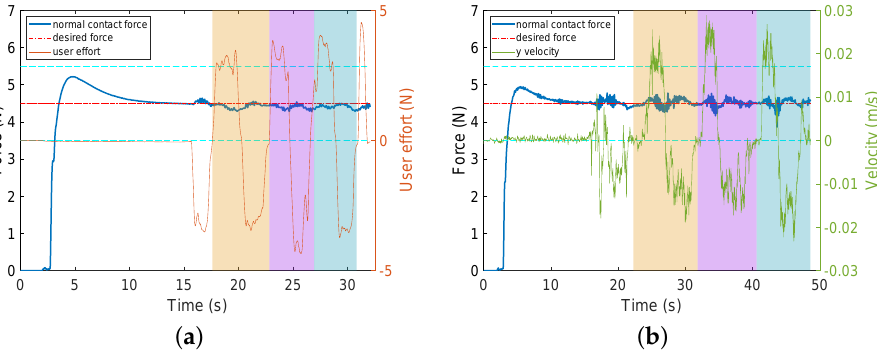
Figure 5. Sample data for US scanning on horizontal tissue surface with different feedback are provided for two modes in Experiment 2a. AF means audio feedback; HF means haptic feedback; FC means force controller. Two horizontal dashed cyan lines define the tolerance area for the desired force. ( a ) AF + FC + HF ( p HRI mode). ( b ) AF + FC ( tele HRI